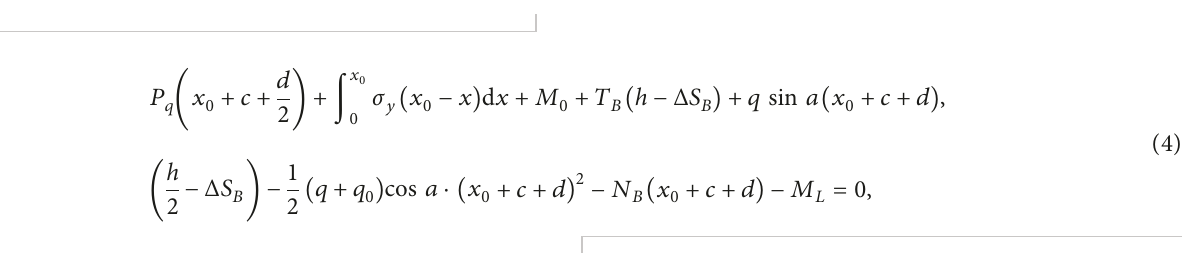
Table 1. Mechanical properties of concrete materials and high-water materials are shown in Table 2.